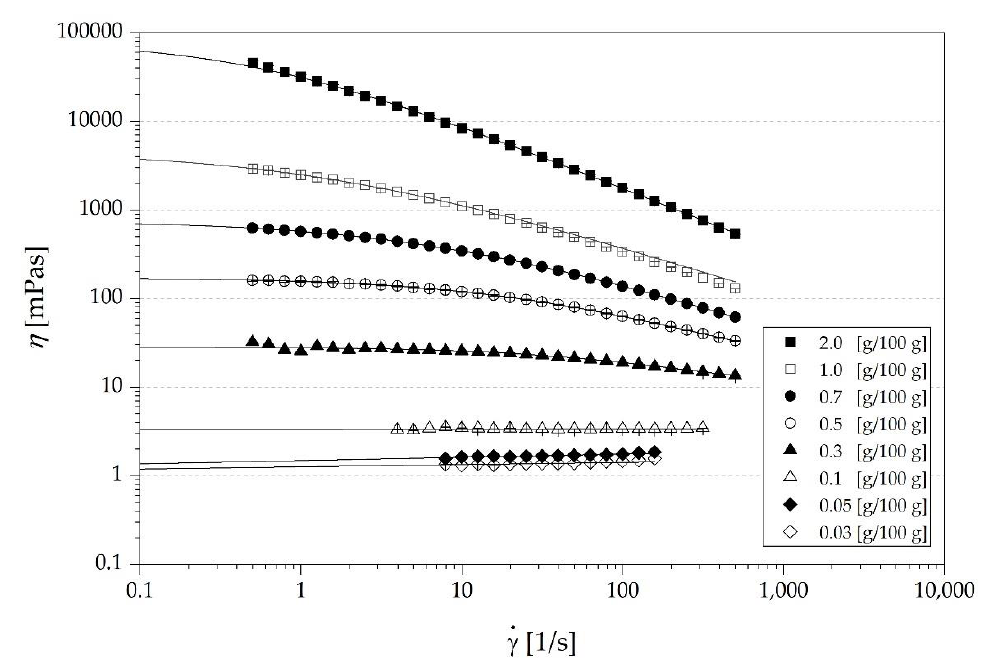
Figure 2. Flow behavior exemplarily shown for the high M W carboxymethyl cellulose solutions (CMC-H) at different concentrations [g/100 g]. Shear rate dependent viscosity appeared for solutions in concentrations above c* (0.3 g/100 g – 2.0 g/100 g). Points correspond to experimental data and lines to fitted data according to Cross equation (Equation (7)) for concentrations of 0.3 – 2.0 g/100 g and Newtonian equation (Equation (8)) for concentrations of 0.03 – 0.1 g/100 g (R 2 ≥ 0.99).